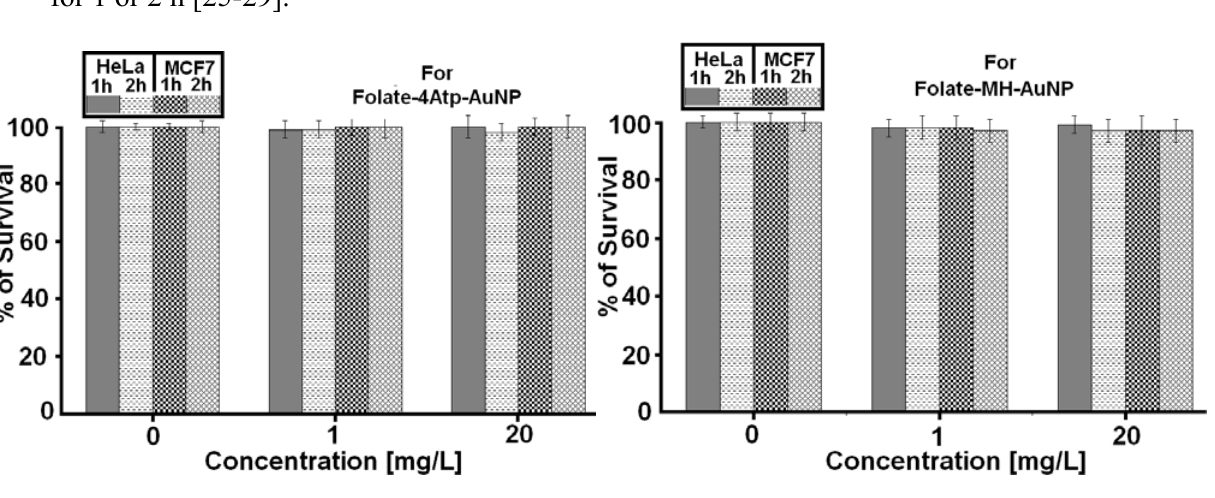
Figure 9. The percentage survival of HeLa and MCF7 cells incubated with different concentrations of nanoconjugates (Left: Folate-4Atp-AuNP and right: Folate-MH-AuNP) for 1 or 2 h